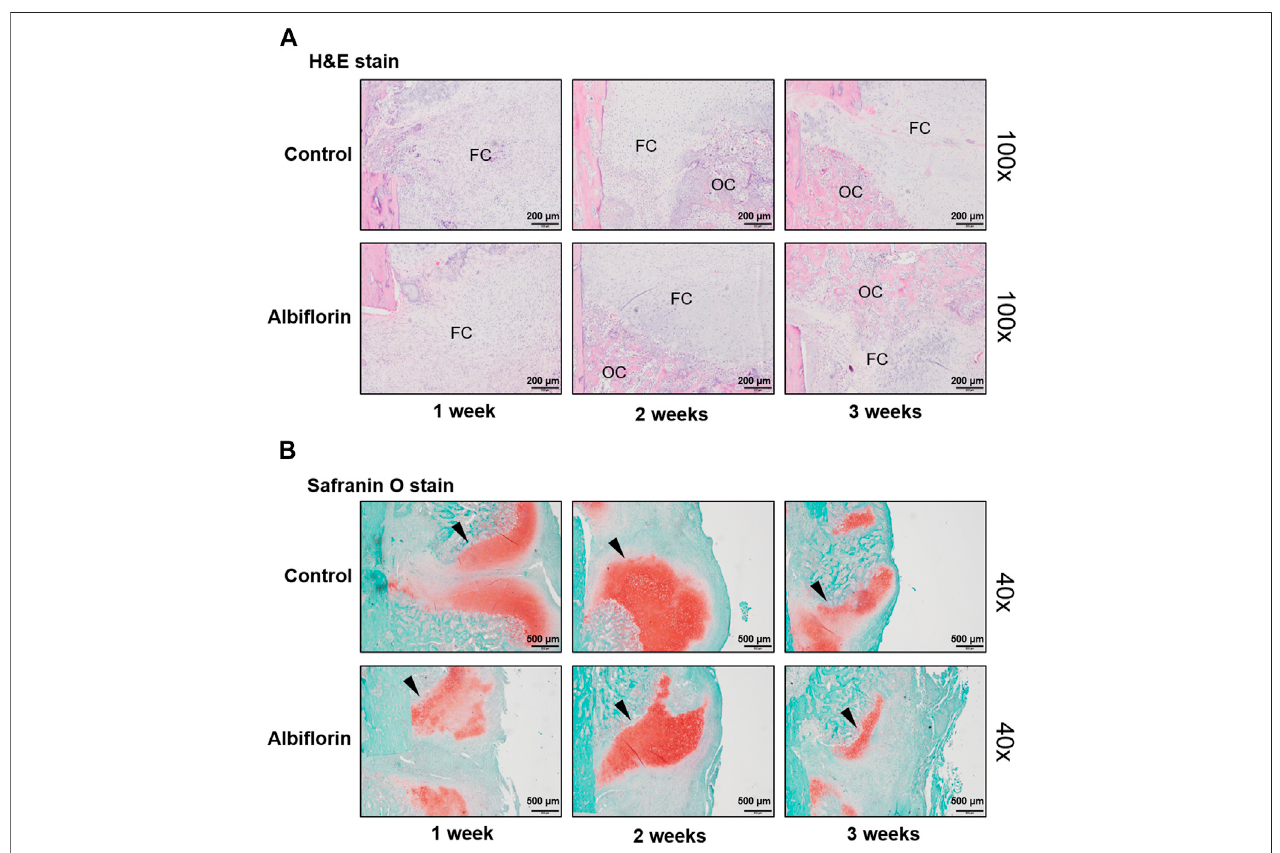
FIGURE10| Effectofalbi fl orinonmorphologicalstructureinfemoraltissue (A) Changesin fi brousandosseouscallusatthefracturesitewereobservedbyHandE staining(magni fi cation: × 100,scalebar:200 µm).TheabbreviationsintheHandEstainingareasfollows:OC,osseouscallus;FC, fi brouscallus (B) Cartilageareasinthe fractured sites were compared by safranin O staining (magni fi cation: × 40, scale bar: 500 µm).